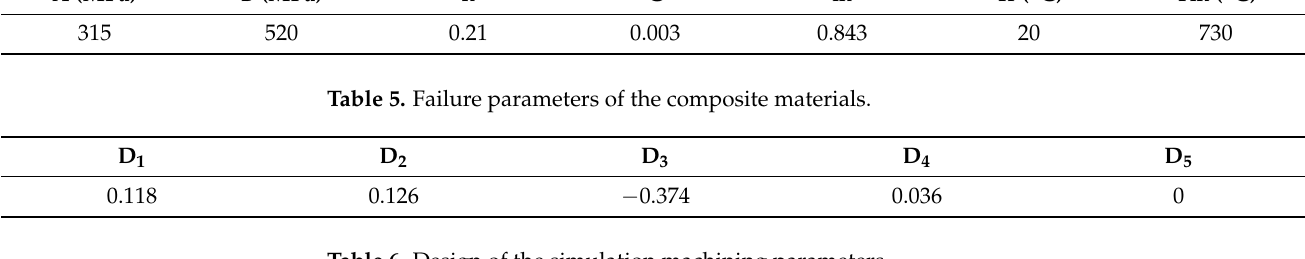
Table 6. Design of the simulation machining